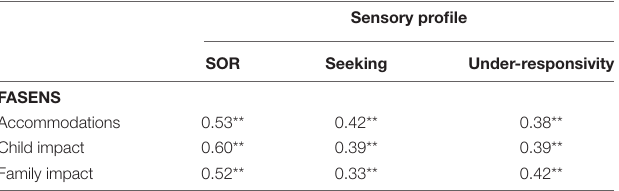
TABLE 3 | Spearman rho correlations between FASENS scores and sensory profile